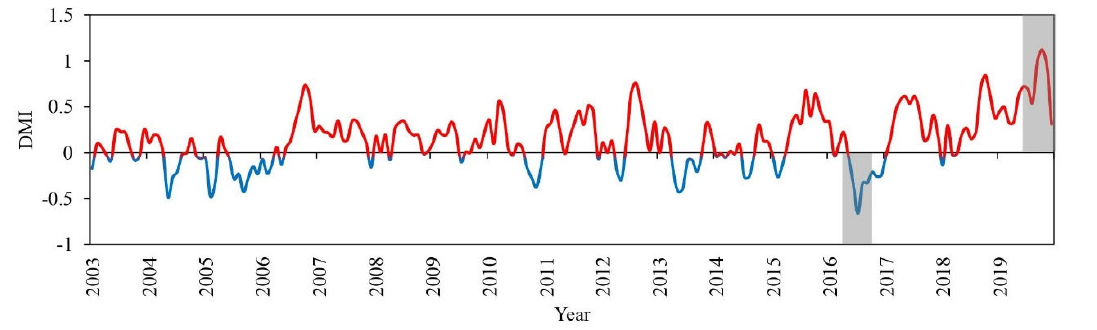
Figure 6. Temporal variation of the DMI for the period from 2003 to 2019, defined as the difference in SST anomalies between the western (50° E–70° E, 10° S–10° N) and eastern (90° E–110° E, 10° S–0° N) Indian Ocean [36]. The blue plot line represents negative IOD, and the red line represents positive IOD.